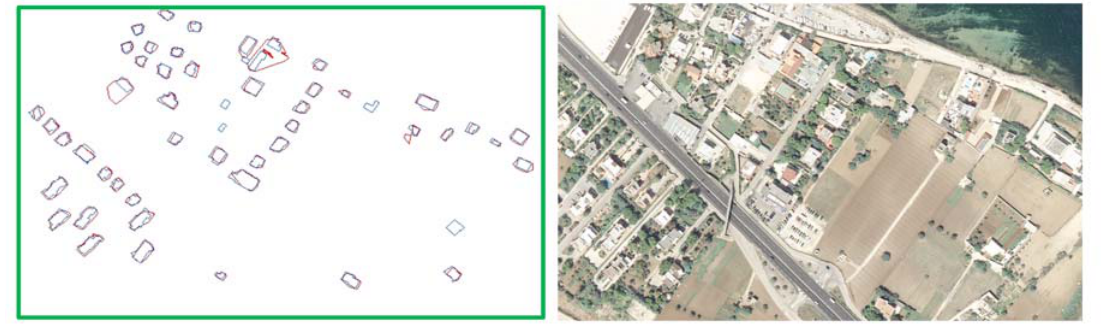
the proposed algorithm (red) and manually edited buildings